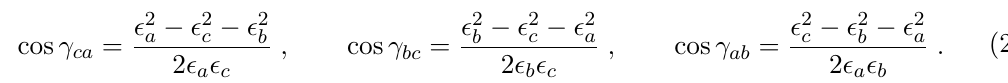
Figure 2 . N=3 and N=4 Figure 1 . Simplest Euclidean Steiner trees with equal weights: (a) N = 3 tree with a single vertex known as the Fermat-Torricelli point, it is inscribed into a triangle, (b) N = 4 tree with two vertices inscribed into a square. (This case was discussed by Courant and Robbins [49]. Curiously, the two Steiner trees look like two OPE channels of the 4-point conformal